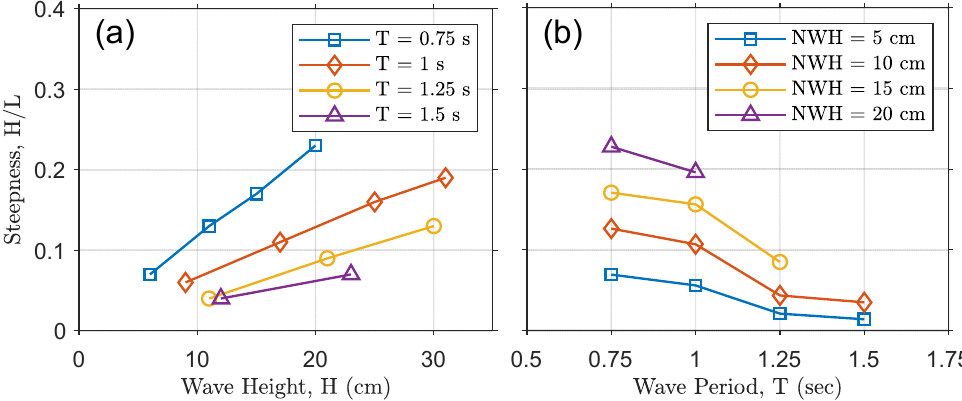
Figure 6. Wave steepness. ( a ) Variation in steepness versus wave height for a given wave period. ( b ) Variation in steepness versus wave period for a measured wave height.